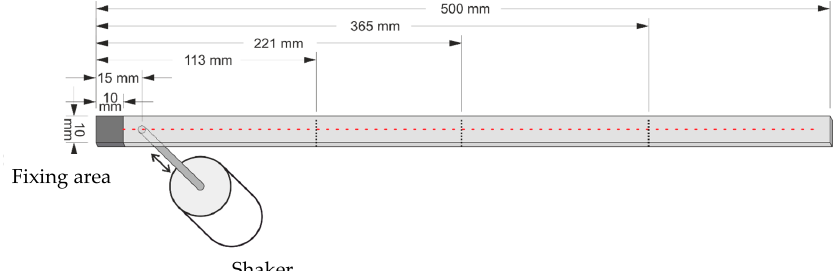
Figure 12. Dimensions in millimeters of cracked beam with shaker and measurement points.